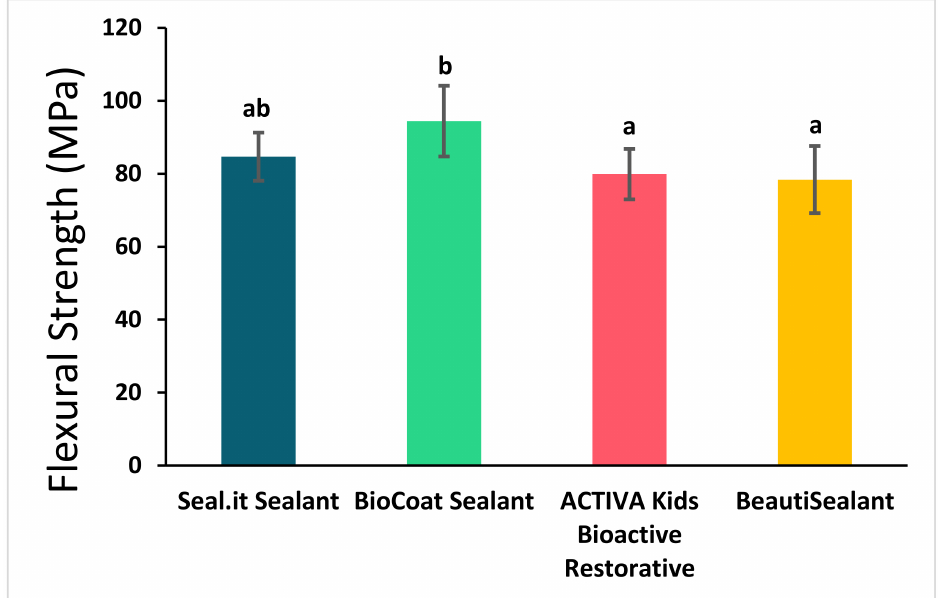
Figure 2. Flexural strength of the studied sealants (mean ± SD). Values indicated by different letters (a,b) are statistically significant and different from each other ( p < 0.05).